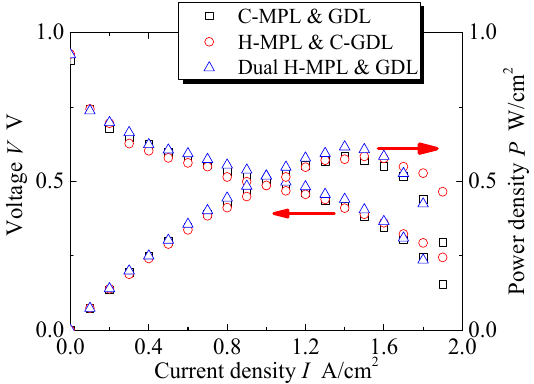
Figure 9. Curves of current density–voltage and current density–power density of PEMFC at 70 °C with different MPL/GDL structures.